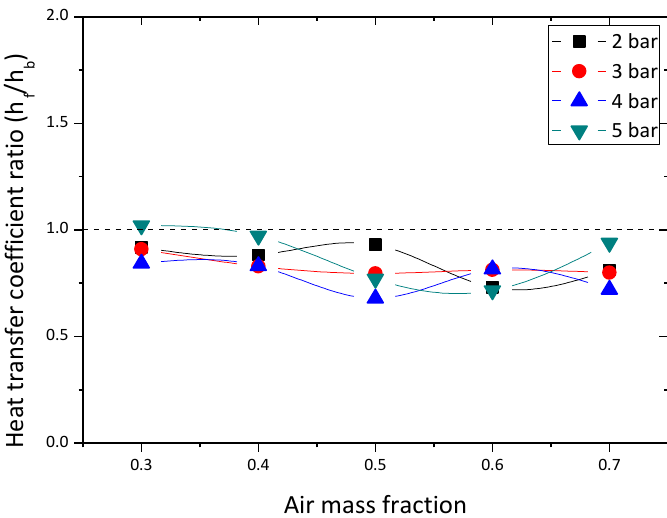
Figure 13. Ratio of the condensation heat transfer coefficient along the air mass fraction at 2, 3, 4, and 5 pressure.